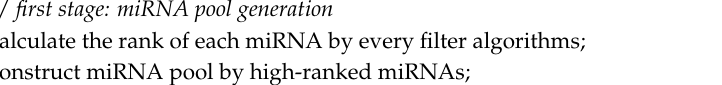
Algorithm 2. Outline of proposed algorithm for feature selection in